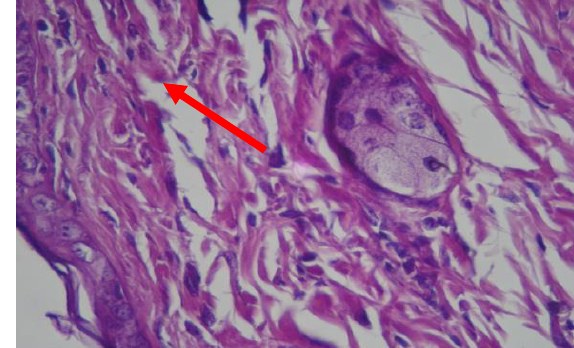
Figure, 10 : Section in the skin of infected non- immunized animal at day 60 post challenge showed dense fungal growth with hyphae that stained red with PAS stain spreading in both dermal and epidermal involving hair follicle (PAS stain400X).